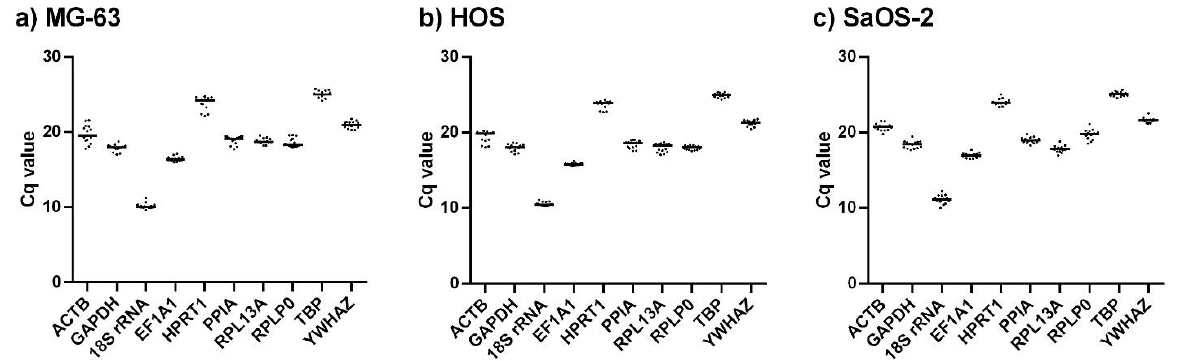
Figure 2. Data distribution and average of measured Cq values at different time points for each tested gene in ( a ) MG-63, ( b ), HOS and ( c ) SaOS-2 cell lines obtained with